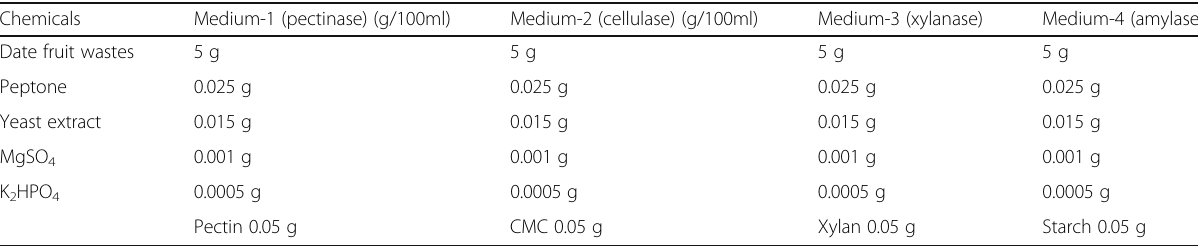
Table 1 Media composition for various enzyme production